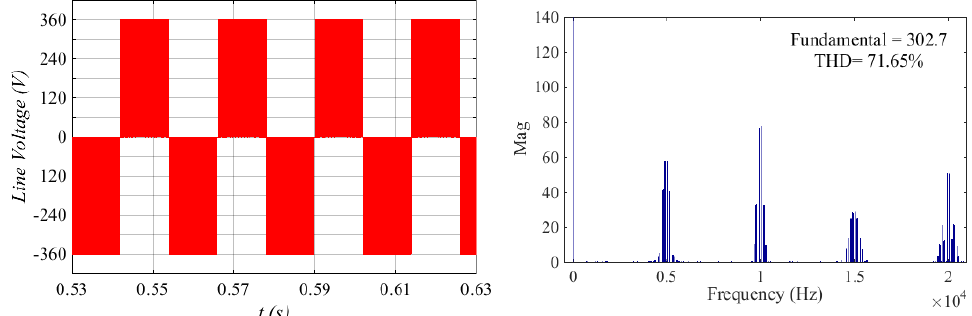
Figure 13. Simulation waveforms of line voltage u ab for DZIPWM at m = 0.9703: ( left ) line voltage u ab ( right ) the FFT analysis of u ab .